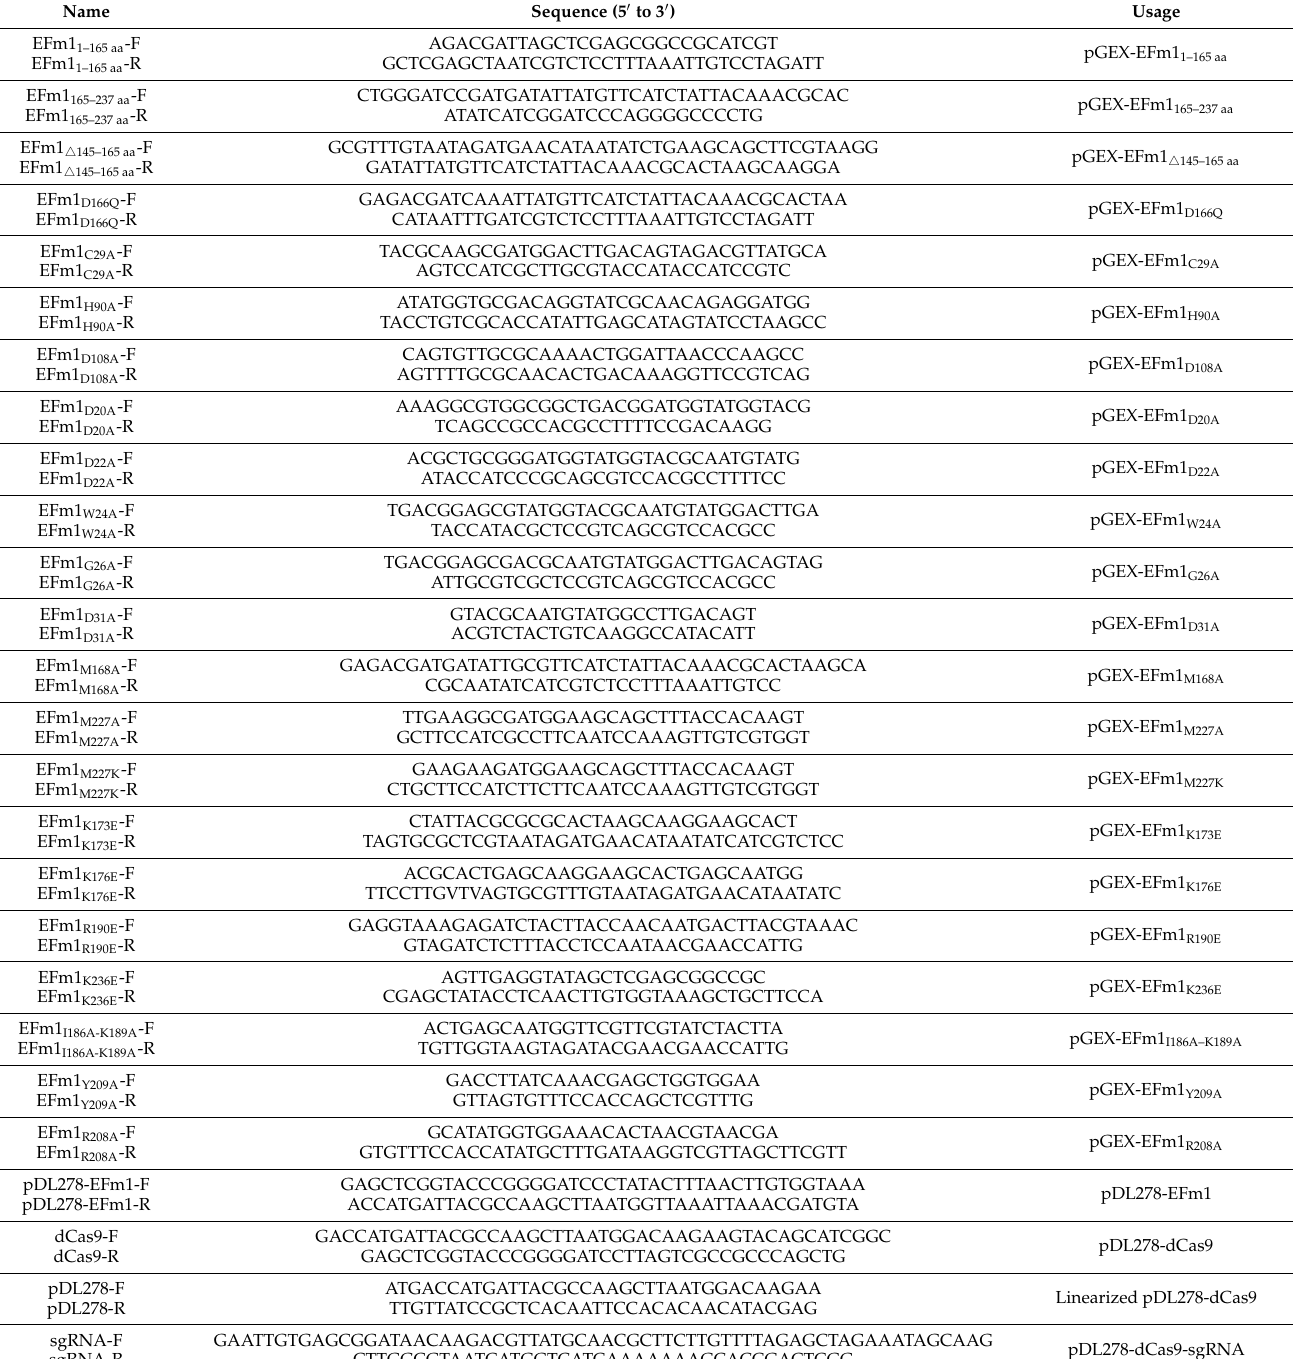
Table 1. Primers used in this